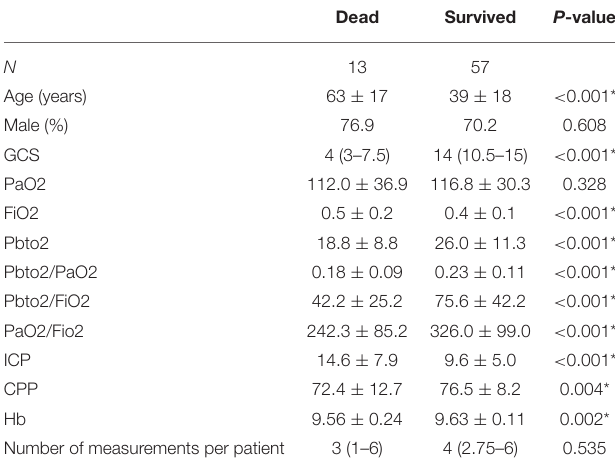
TABLE 1 | Baseline data of study